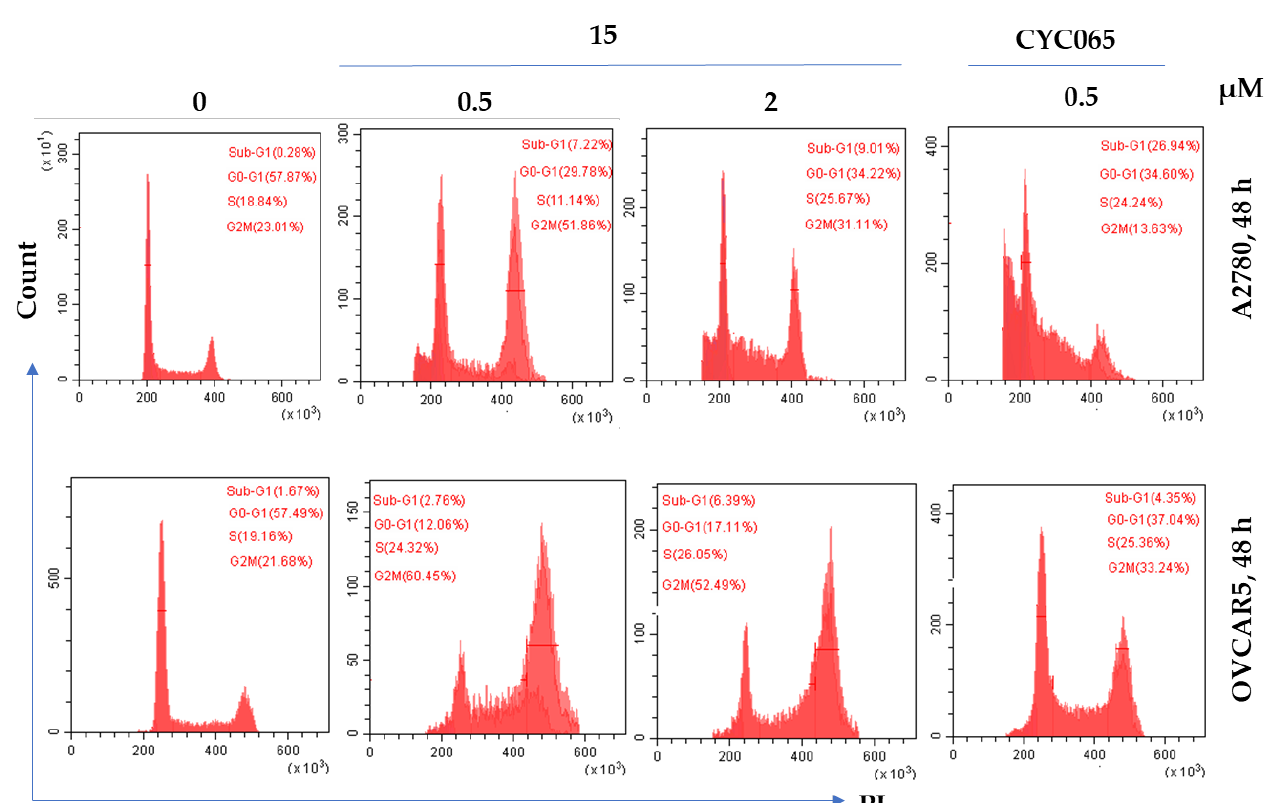
Figure 4. Effects of 15 on the cell cycle progression of A2780 and OVCAR5 ovarian cancer cells. Cells were incubated with 15 at 0.5 or 2 µ M or CYC065 at 0.5 µ M for 48 h. DMSO diluent was employed as a control. The experiments were performed twice, and representative data are